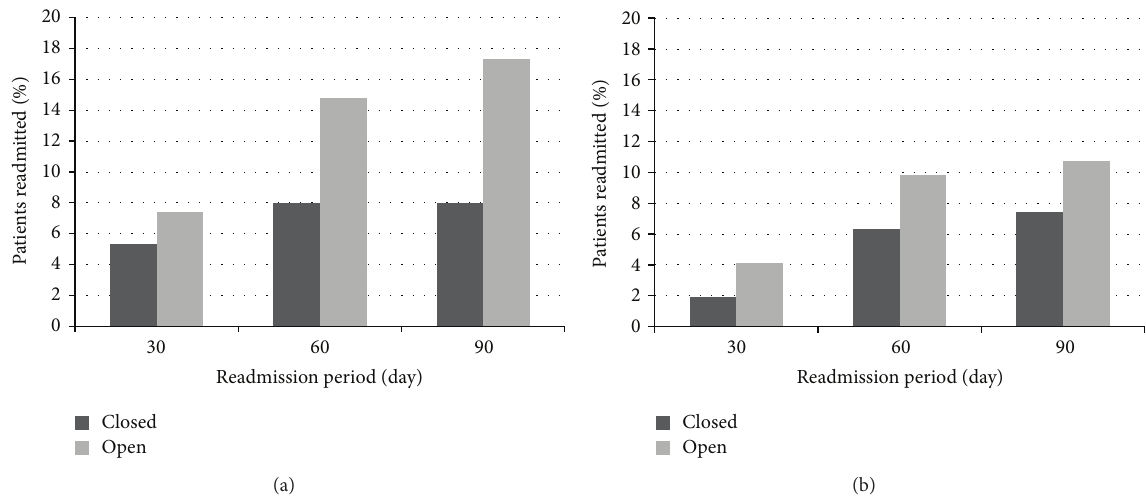
Figure 1: (a) 30-Day, 60-day, and 90-day readmission rates for isolated diaphyseal tibia fractures. (b) 30-Day, 60-day, and 90-day readmission rates for isolated diaphyseal femur fractures. Note . All orthopaedic trauma surgery patients who presented with a diaphyseal tibia or femur fracture to VUMC between January 1, 2004, and December 31, 2006, were included in this analysis. (a) compares 30-day, 60-day, and 90-day readmission for closed tibia and open tibia fractures. (b) compares 30-day, 60-day, and 90-day readmission for closed femur and open femur fractures.